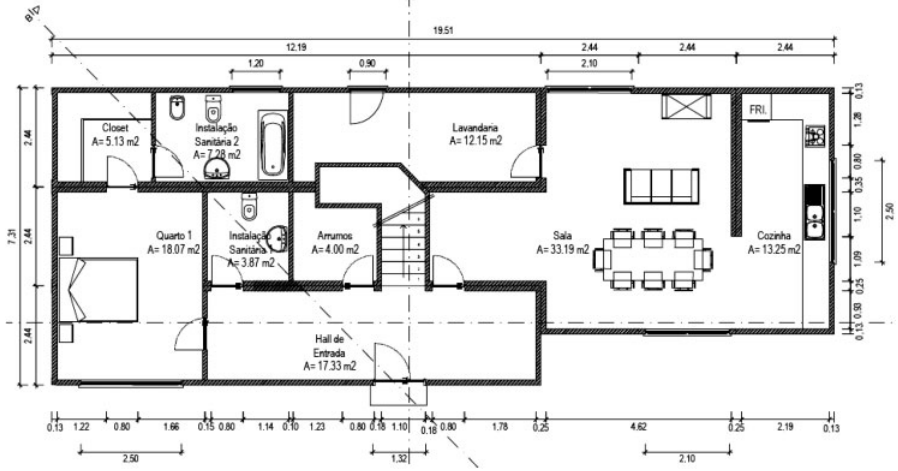
Fig. 9. Single family house: Floor